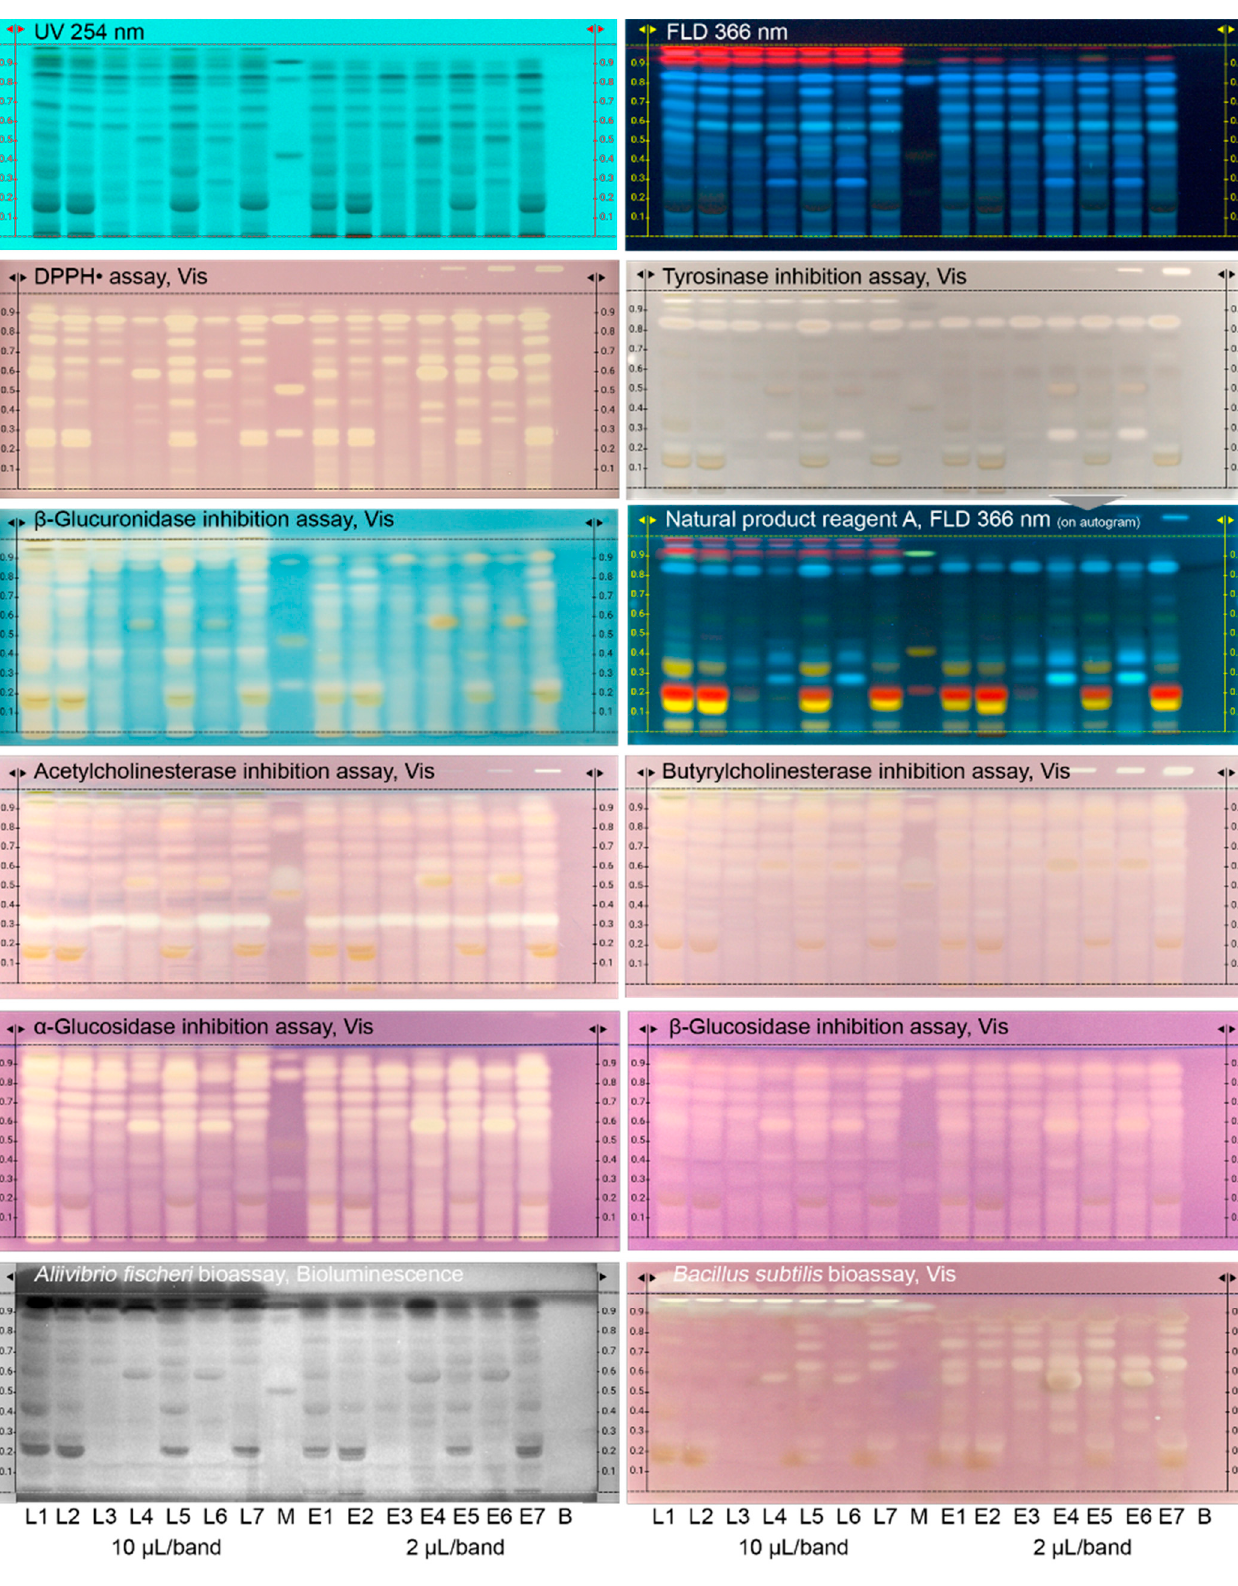
Figure 1. Bioprofiling of 14 peppermint products for 9 different bioactivity mechanisms: HPTLC– Vis/UV/FLD chromatograms of the various leaf samples L1–L7 (Table 1; all extracted/dissolved with water—ethanol—ethyl acetate 1:1:1; 10 µ L/band each) and respective powdered extracts E1–E7 (2 µ L/band each) along with standard mixture (M; eriocitrin, luteolin-7- O -glucoside, rosmarinic